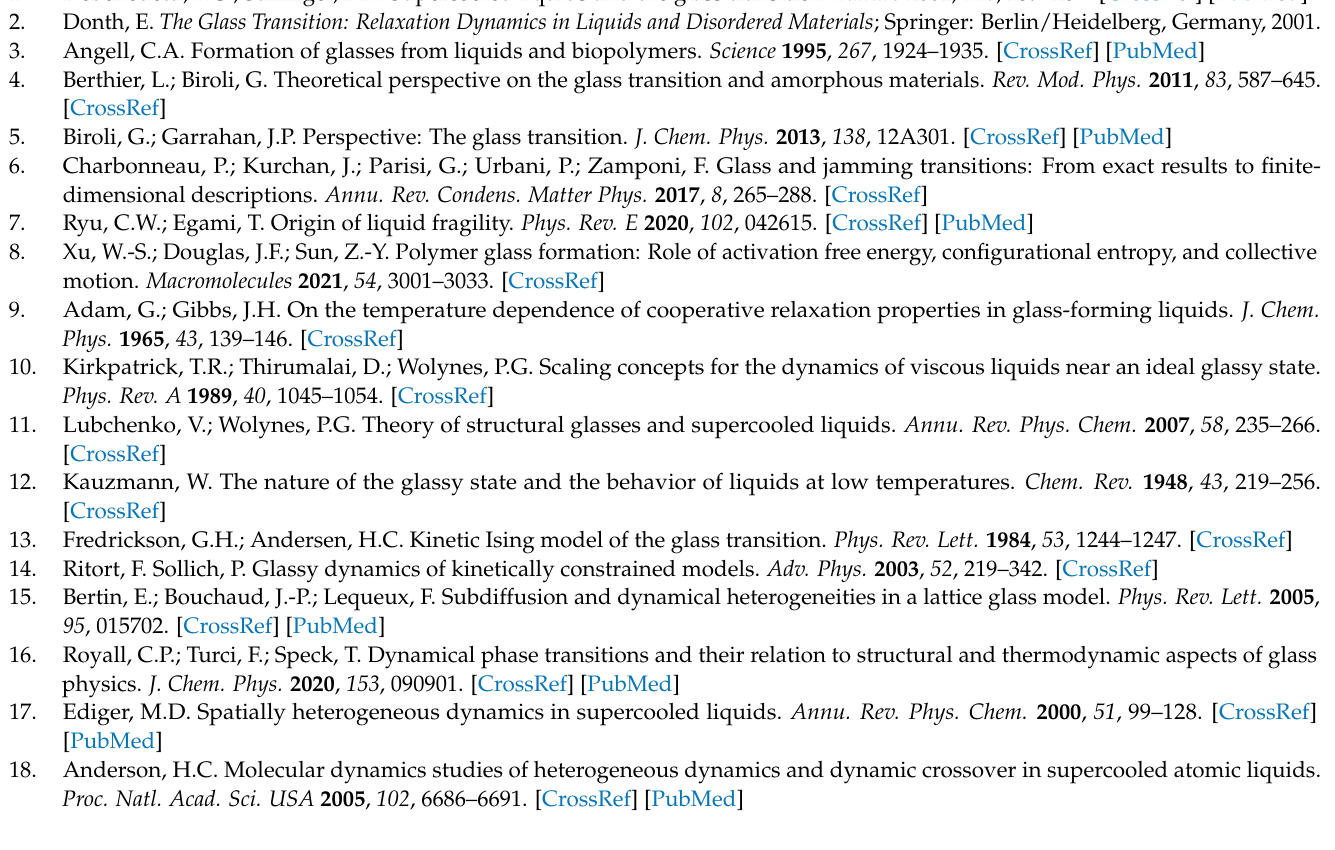
10.3390/polym13193424/s1, Figure S1: The probability of dynamical coupling with neighboring segments, Figure S2: Plot of log N vs. log R g at T * = 3.063 and 4.376, Figure S3: Plot of log N nc vs. log R g at T * = 3.063 and 4.376, Figure S4: Relaxation time with respect to temperature for ethylbenzene, salol, o -terphenyl, PDMS, PBD, and low M w PMMA, Table S1: Obtained fitting parameters in Equation